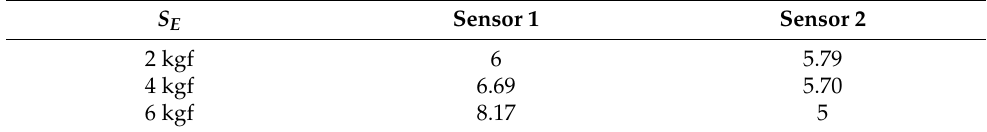
Table 5. Result of sensor data efficiency evaluation for optimal sensor selection of doctor blade tilting